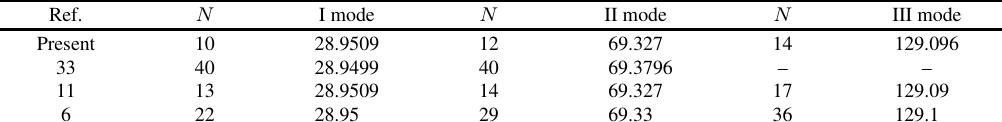
Table 3 Convergence of frequency parameter Ω for homogeneous ( μ = β = 0 ) isotropic C-C plate; for b/a = 1 ,N ∗ 0 = 0 ,p = 1